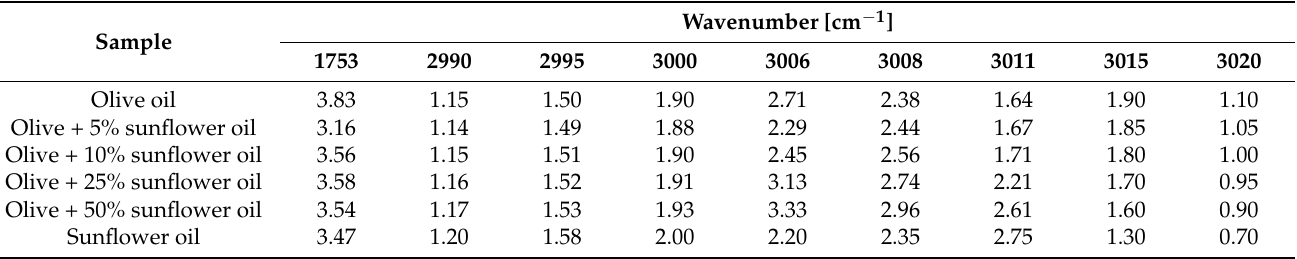
Table 3. IR absorption for olive and sunflower oils and for their mixture according to [118], modified.